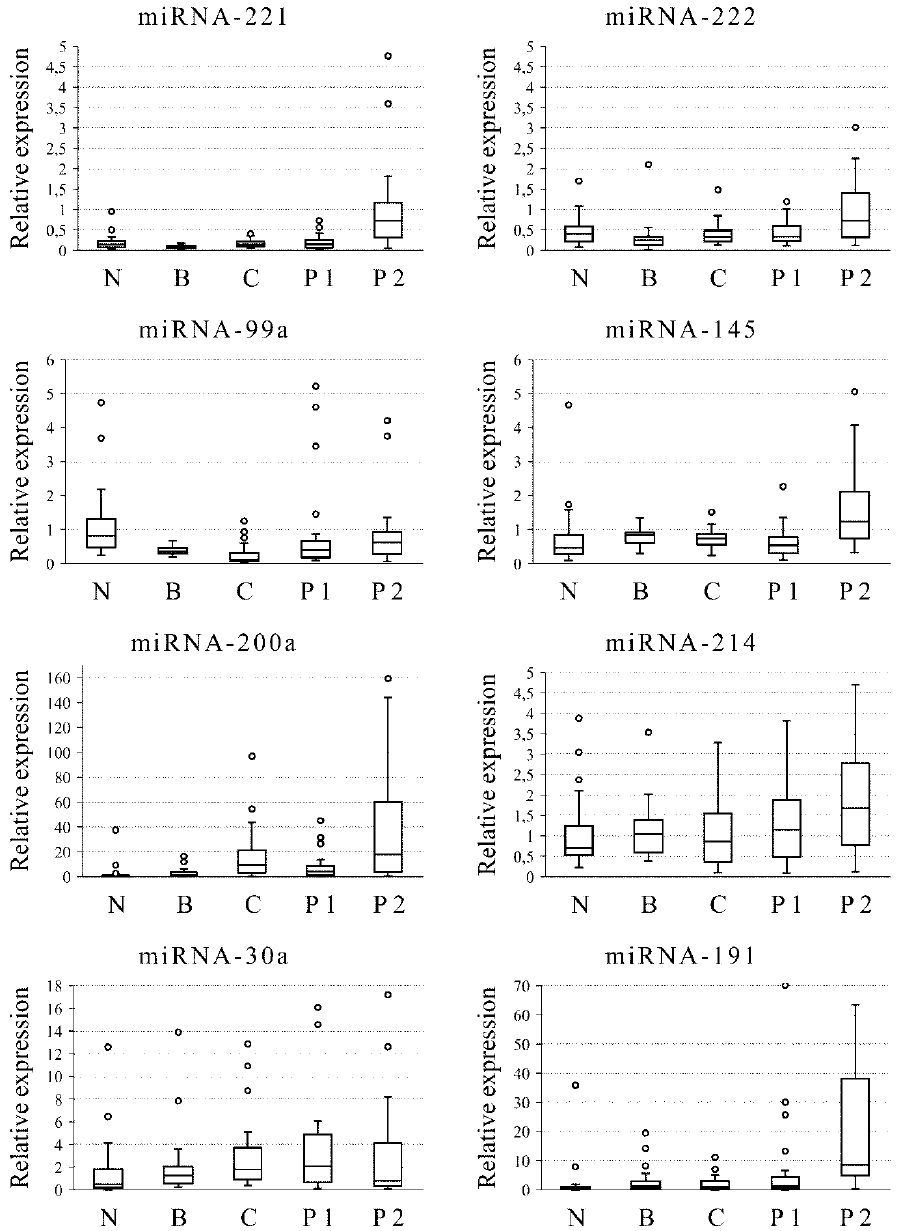
Figure 1. Comparative analysis of miRNA expression levels between specimens taken from different intratumor areas: tumor center (C), two tumor peripheries (P1 and P2), and tumor borders (B) with normal mammary gland tissue (N). Shown are the median value, the upper and the lower quartiles, the outlier-free range, and outliers (appear as circles).